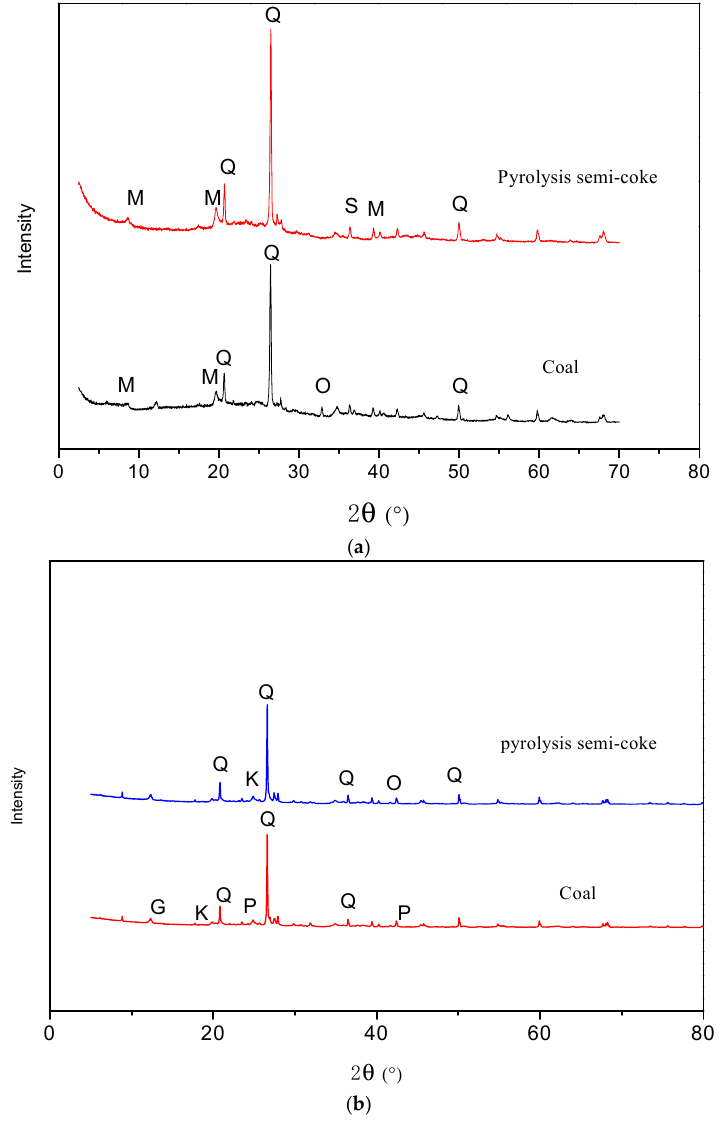
Figure 4. XRD patterns of coal and semi-coke (800 °C). ( a ) Ulanqab lignite; ( b ) Ulankarma lignite. Q—quartz; M—muscovite; S—sanidine; O—orthoclase; K—kaolinite; G—gypsum; P—pyrite.